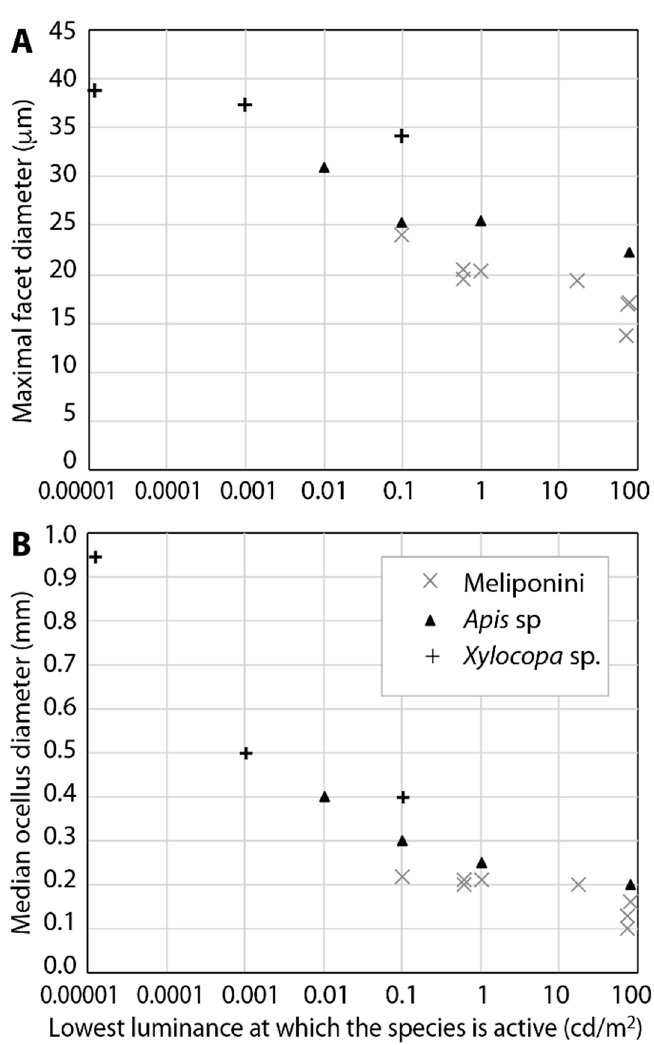
Figure 2. Ommatidial facet size ( A ) and median ocellus diameter ( B ) in bees flying at different light intensities: bee species with larger facets and larger ocelli fly at dimmer light intensities than species with smaller facets and smaller ocelli. Inset in ( B ) also applies to ( A ). Data from [18,21,33,102]. See [103] for a comparison of luminance and illuminance values.